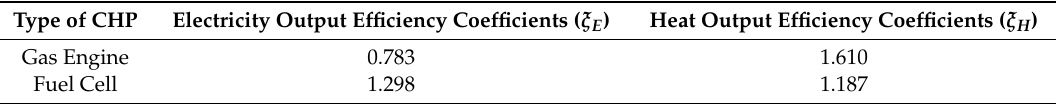
Table 2. Summary of gas engine and fuel cell CHP electricity and heat output efficiency coefficients.